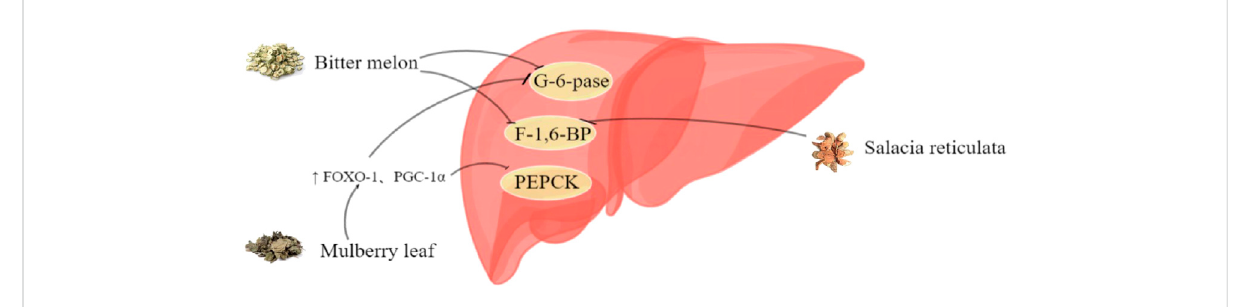
FIGURE 5 Inhibitory effect of herbal teas on gluconeogenesis.